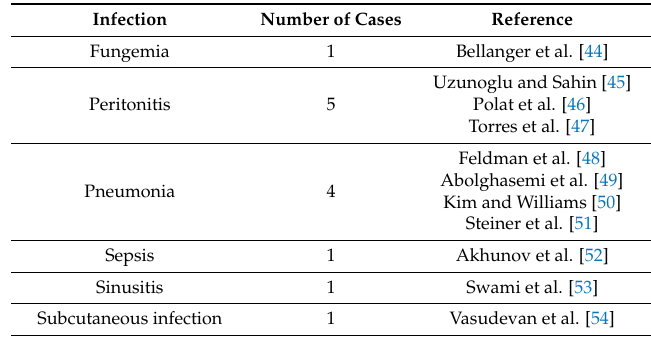
Table 1. Reported human cases of hyalohyphomycosis caused by Paecilomyces variotii between 2013 and